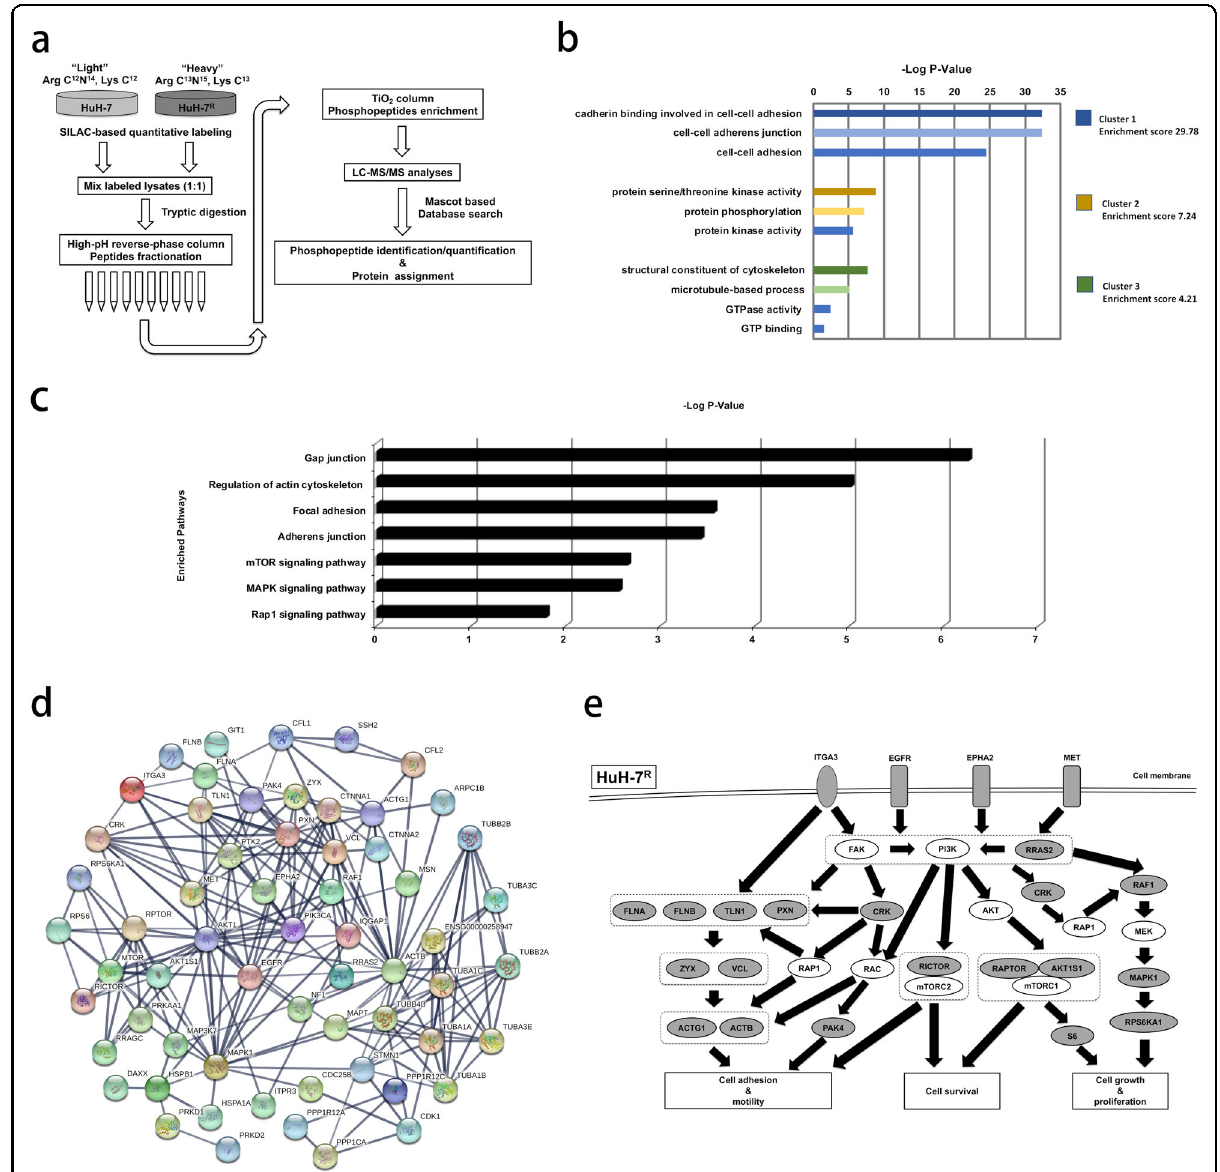
Fig. 1 Differential phosphoproteomics between parental (HuH-7) cells and cells with acquired resistance to sorafenib (HuH-7 R ). a Work fl ow for quantitative phosphoproteomic analyses between parental (HuH-7) and HCC cells with acquired sorafenib resistance (HuH-7 R ) via SILAC-based mass spectrometry. Heavy and light cell lysates were mixed and digested with trypsin and fractionated by high-pH reverse-phase chromatography. Phosphopeptides were then puri fi ed with TiO 2 column and analyzed in an LTQ-Orbitrap Velos hybrid mass spectrometer. b Clustered gene ontology functional enrichment was assessed with DAVID. Upregulated phosphoproteins in HuH-7 R cells showing a SILAC fold change H/L ≥ 1.5 were analyzed. The top three functional clusters are listed. − Log ( p values) and enrichment scores are presented. c Pathway enrichment analysis of the upregulated phosphoproteins in HuH-7 R cells based on the KEGG pathway database with DAVID. Pathways with p values < 0.05 are shown. d Interaction linkage analysis of the molecules in enriched pathways shown in c with STRING. The connected molecules are shown. e Schematic representation of the postulated dysregulated phosphoprotein functional network in sorafenib-resistant HCC (HuH-7 R ) cells. Gray, identi fi ed upregulated phosphoproteins; white, molecules that are postulated but not de fi ned; black bold arrows, signaling